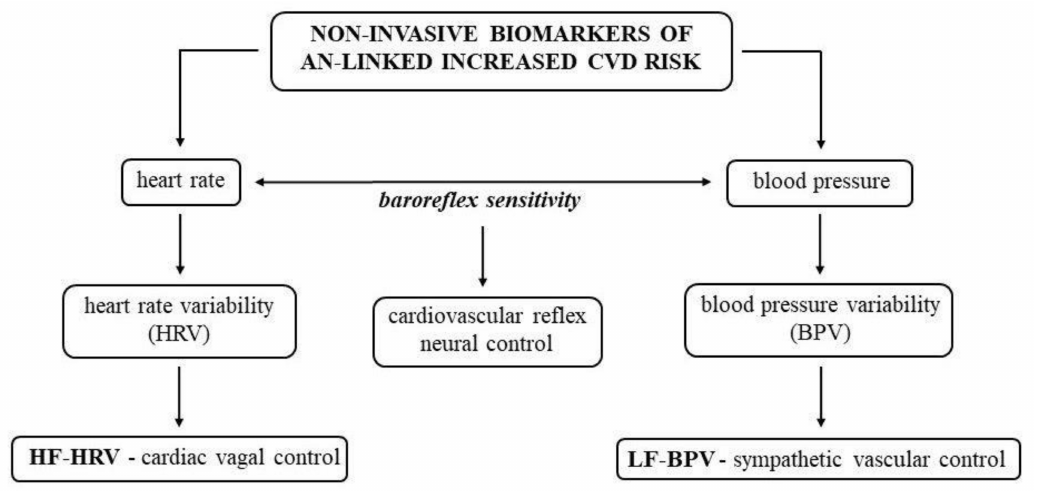
Figure 2. Potential non-invasive biomarkers for detection of the increased cardiovascular diseases (CVD) risk in anorexia nervosa (AN). HF-HRV, high frequency band of heart rate variability; LF-BPV, low frequency band of blood pressure